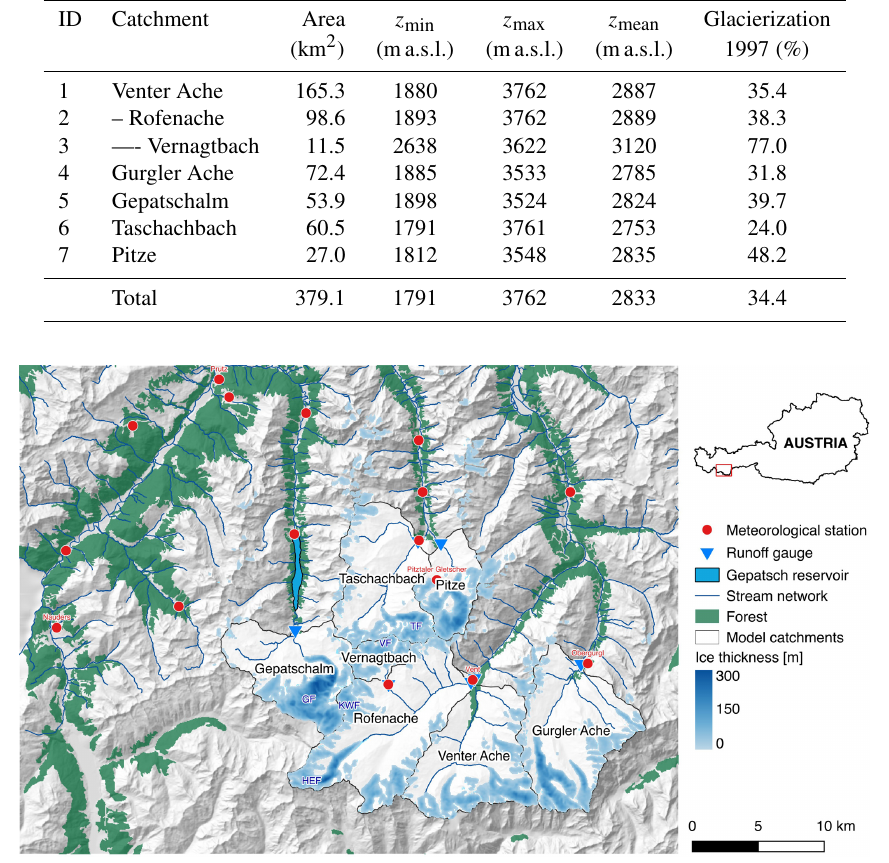
Figure 1. Location and topography of the study site including forested areas, catchment boundaries, the locations of the meteorological stations and runoff gauges, and the calculated initial ice thickness distribution for the year 1997. Selected meteorological stations and glaciers explicitly mentioned in the article are labeled in red and blue, respectively. Glacier abbreviations refer to Hintereisferner (HEF), Kesselwandferner (KWF), Vernagtferner (VF), Taschachferner (TF), and Gepatschferner